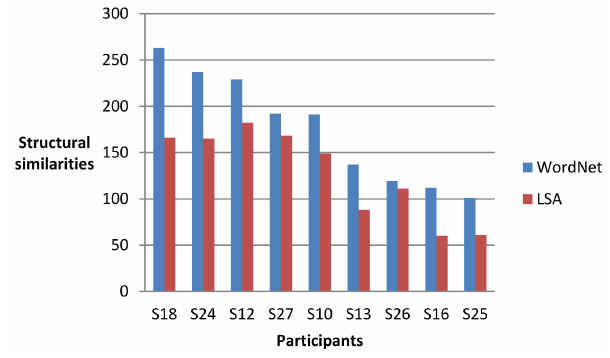
Figure 15. Hierarchical cluster tree computed from the accumulated conditional probability density estimates ob- tained after 2 classifications of 640 brain wave samples (S18) for { London, Moscow, Paris, north, south, east, west, Germany, Poland,Russia }. For all successive runs, the accumulated similarity tree did not change.